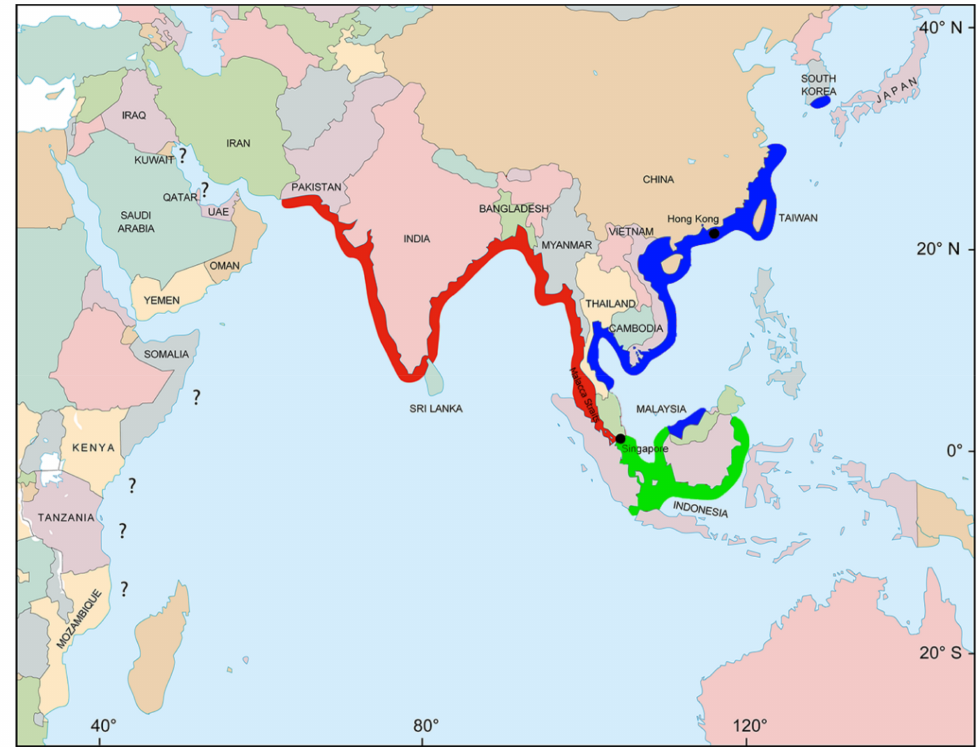
Figure 6. Map of the Indo-West Pacific region showing the refined range of Scoliodon species based on the materials examined and a critical examination of the literature. Dubious range locations are highlighted with a question mark. Red = S. laticaudus , blue = S. macrorhynchos , and green = Scoliodon sp. (verification